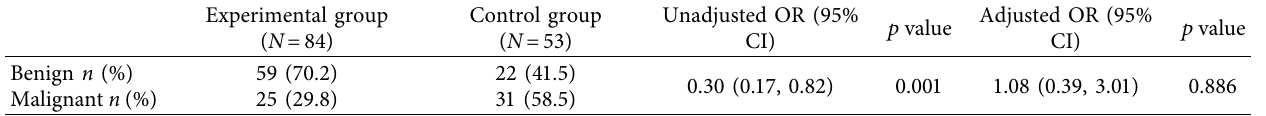
Table 3: The ratio of malignant tumors on the a-side of the experimental group and the control group. Experimental group